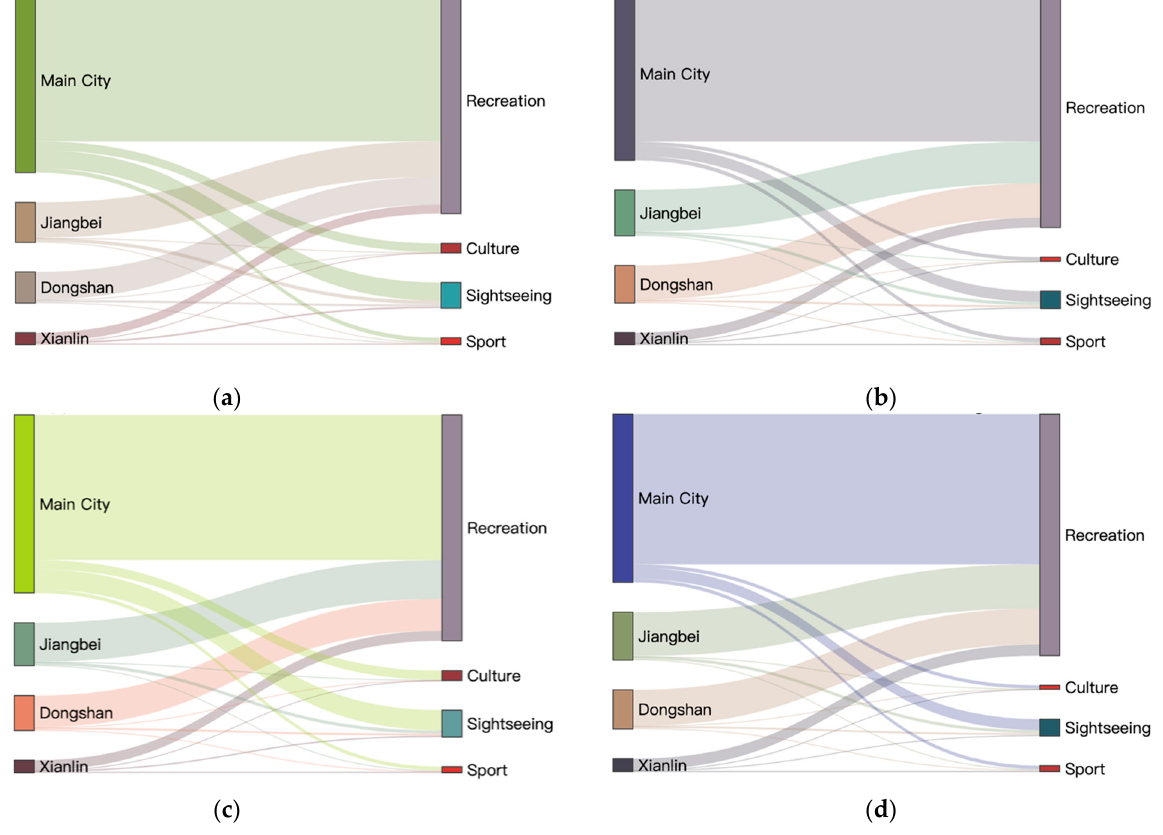
Figure 6. Leisure activity choices of the four districts: ( a , b ) show the leisure activity choices during weekday afternoons and nights; ( c , d ) show the leisure activity choices during weekend afternoons and weekend nights.